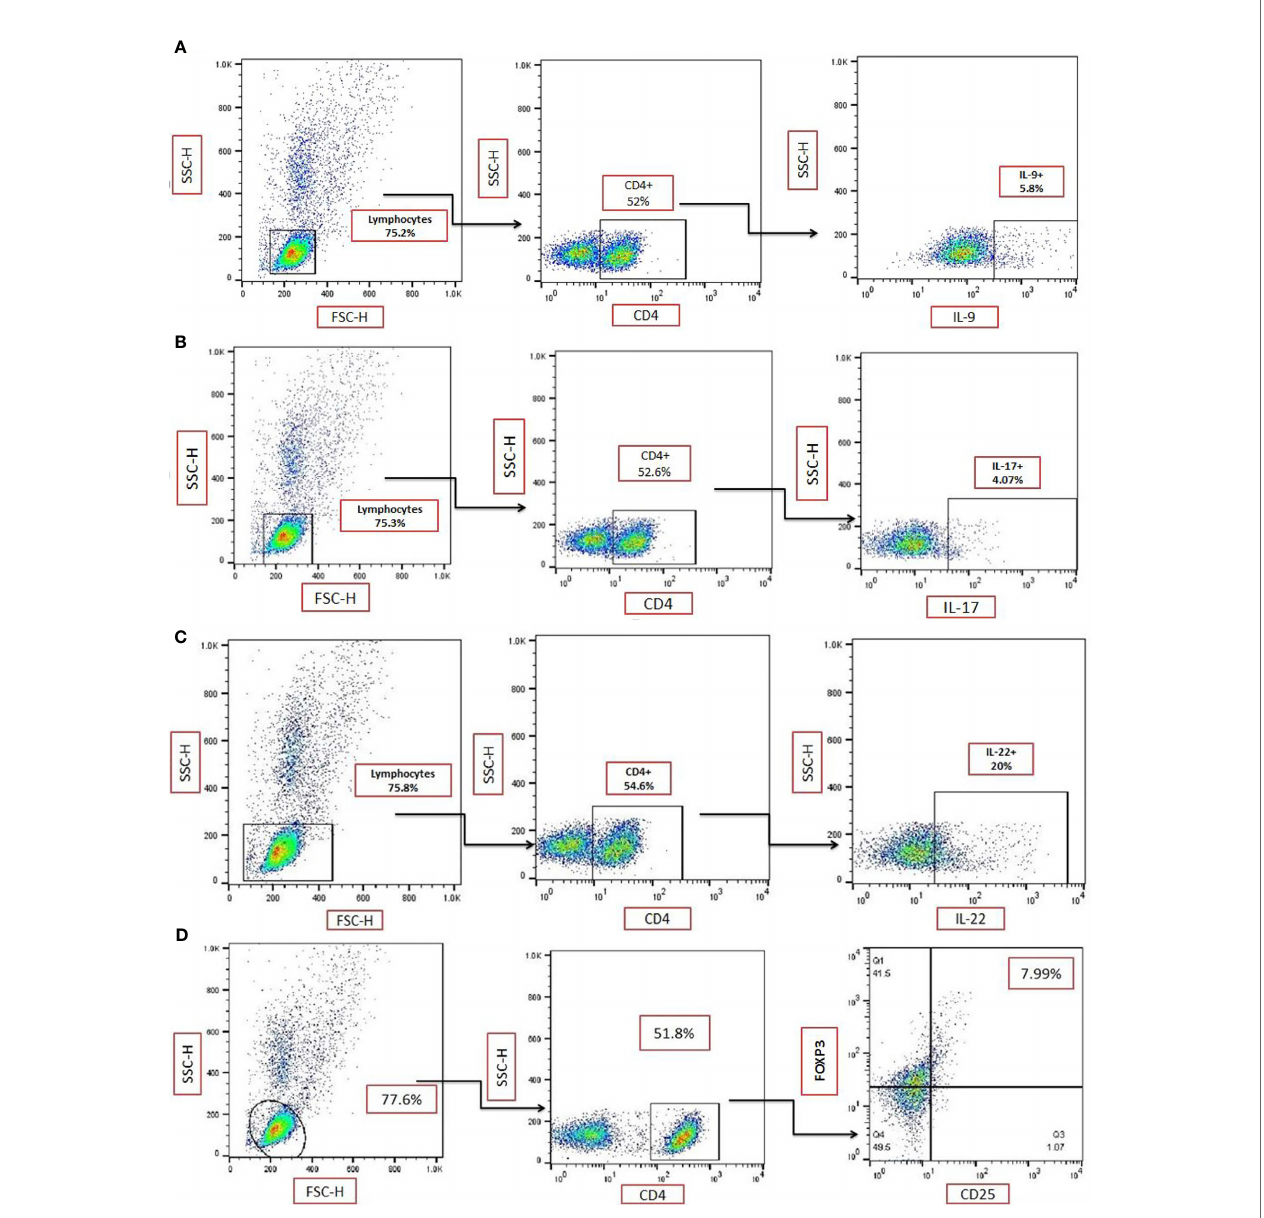
FIGURE 2 | Gating strategy for identi fi cation of T-cell subsets. Representative fl ow cytometric dot plots showing expression of (A) IL-9 on CD4+ T-cells in a sample from a patient with a tuberculous pleural effusion (TPE). (B) Representative fl ow cytometric dot plots showing the expression of IL-17 on CD4+ T cells in a single TPE sample. Data from (A, B) are from duplicate samples from the same donor. (C) Representative fl ow cytometric dot plots showing the expression of IL-22 on CD4+ T cells in a TPE sample. (D) Representative fl ow cytometric dot plots showing expression of CD25+FOXP3+ on CD4+ T cells in a TPE subject. TPE, tuberculous pleural